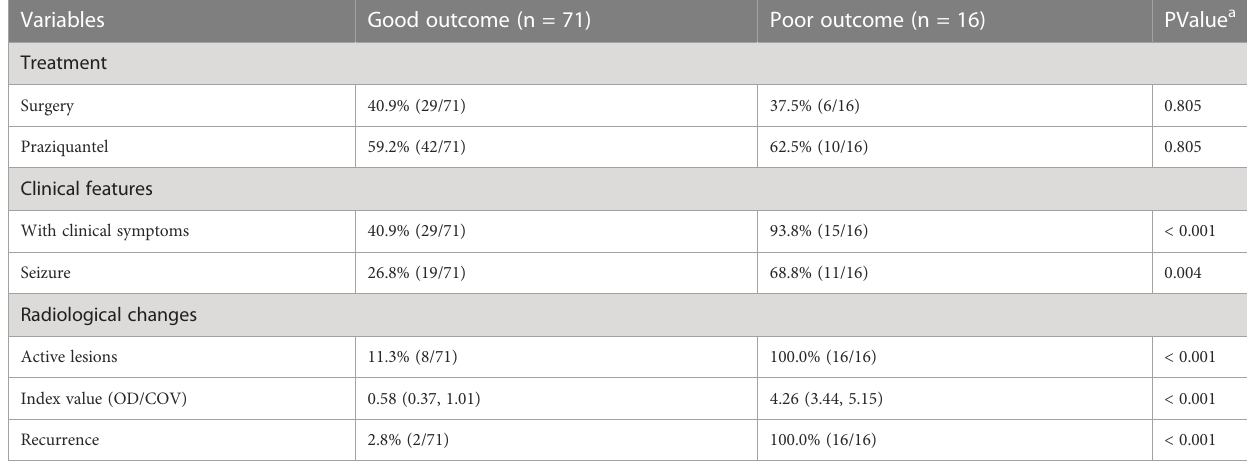
TABLE 4 Comparison of patients with different prognoses after treatment. Variables